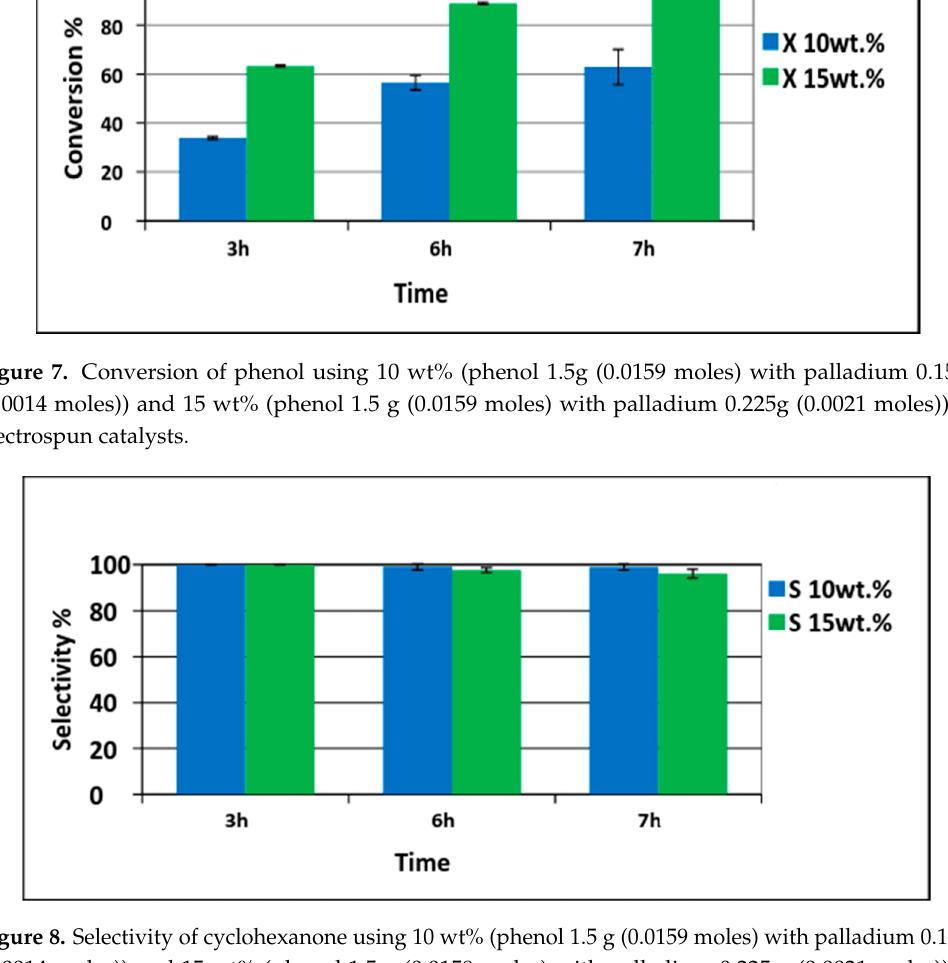
Figure 8. Selectivity of cyclohexanone using 10 wt% (phenol 1.5 g (0.0159 moles) with palladium 0.15 g (0.0014 moles)) and 15 wt% (phenol 1.5 g (0.0159 moles) with palladium 0.225 g (0.0021 moles)) of electrospun catalysts.